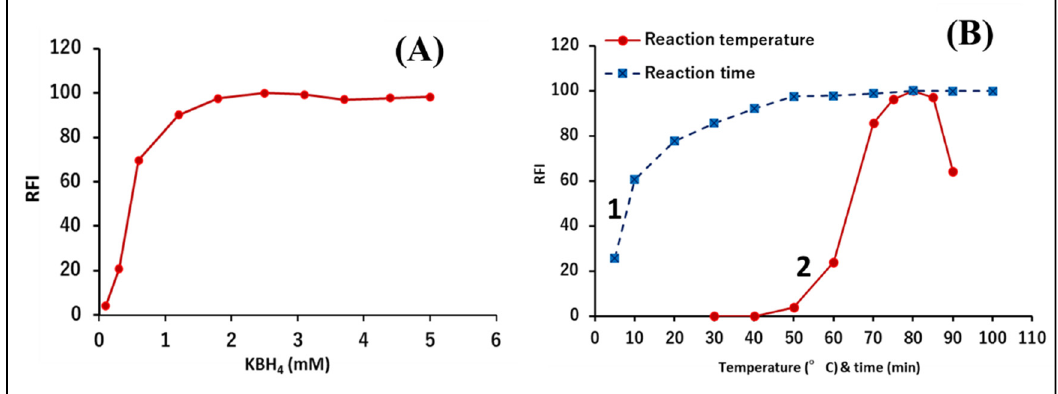
Figure 3. Effect of ( A ) concentration of the reducing agent, potassium borohydride, ( B ) the reaction time (1) and temperature (2) on the relative fluorescence intensity of the reduced NFZ.